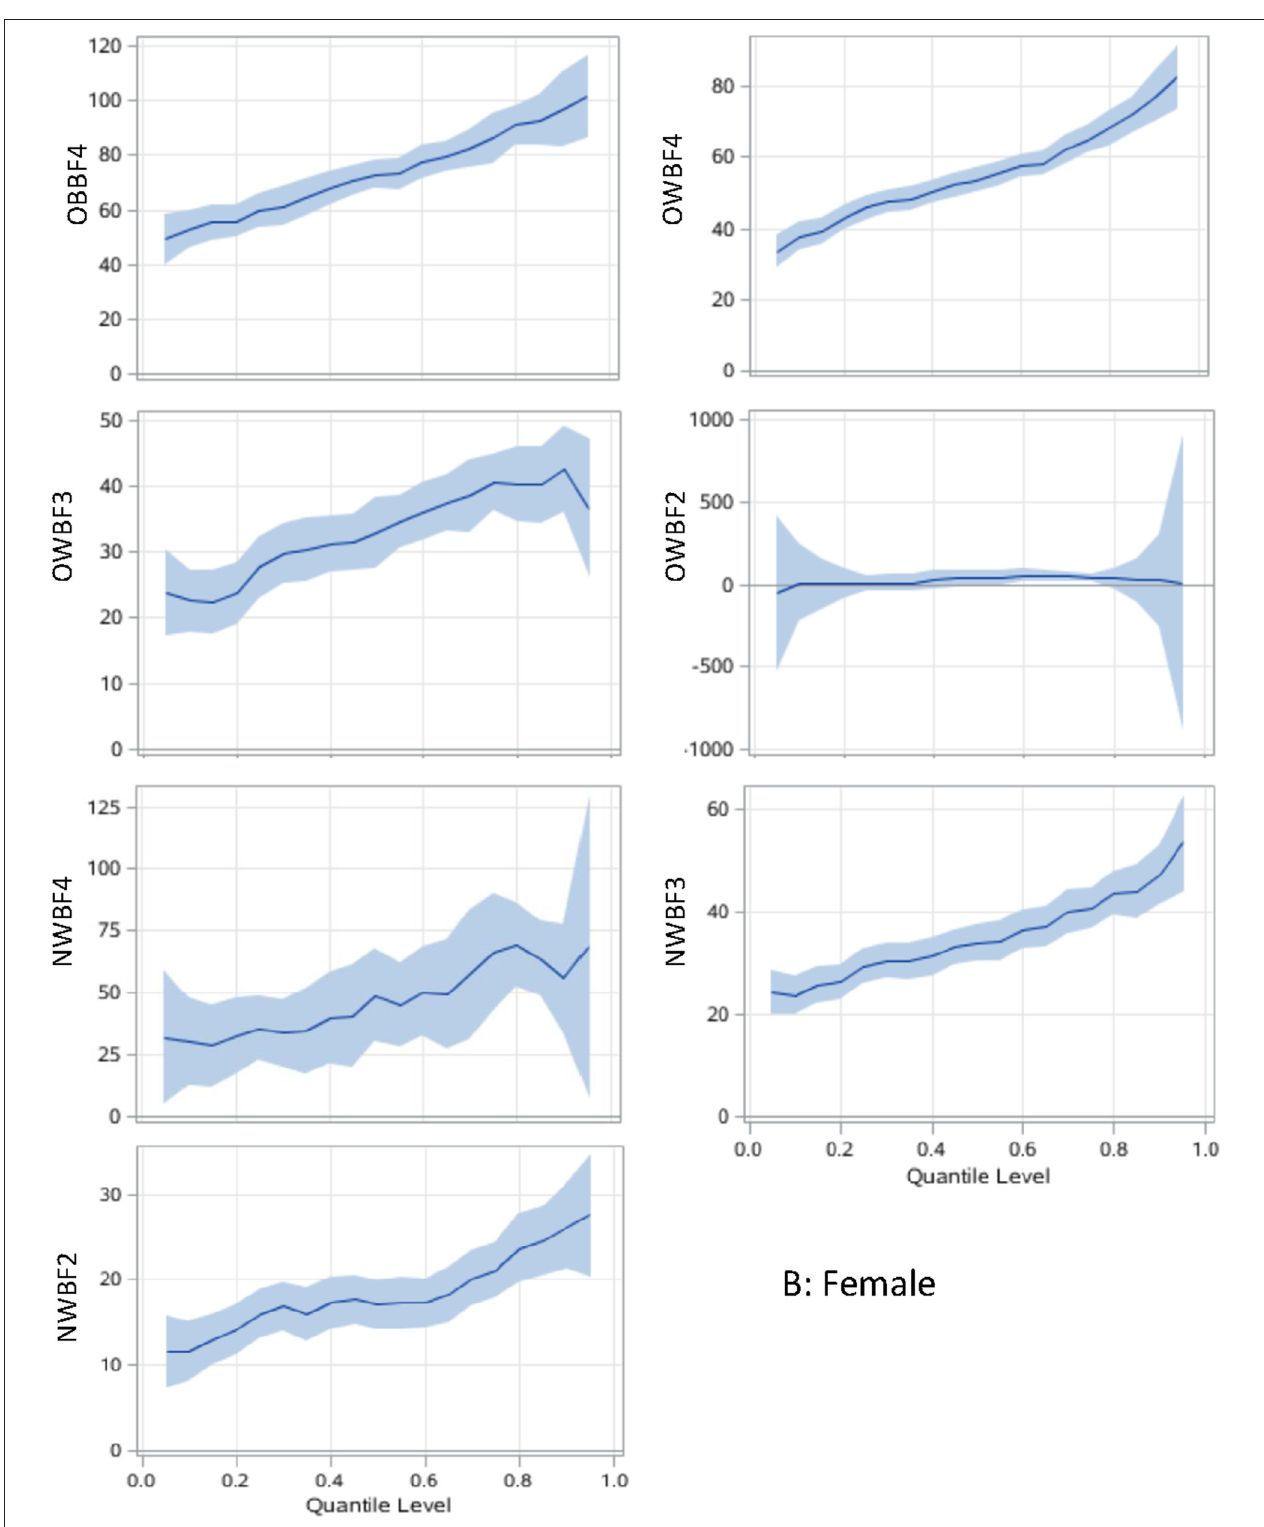
FIGURE 2 | Body adiposity associations with SUA among women using quantile regression models. The under/normal weight group with the lowest %BF quartile is the reference group. The models are adjusted for age, study sites, residential areas, educational attainment, and alcohol consumption. The x-axis is the quantile level of SUA, and the y-axis is the difference of SUA level between the current group and the reference group. The solid lines represent the estimated effect of the